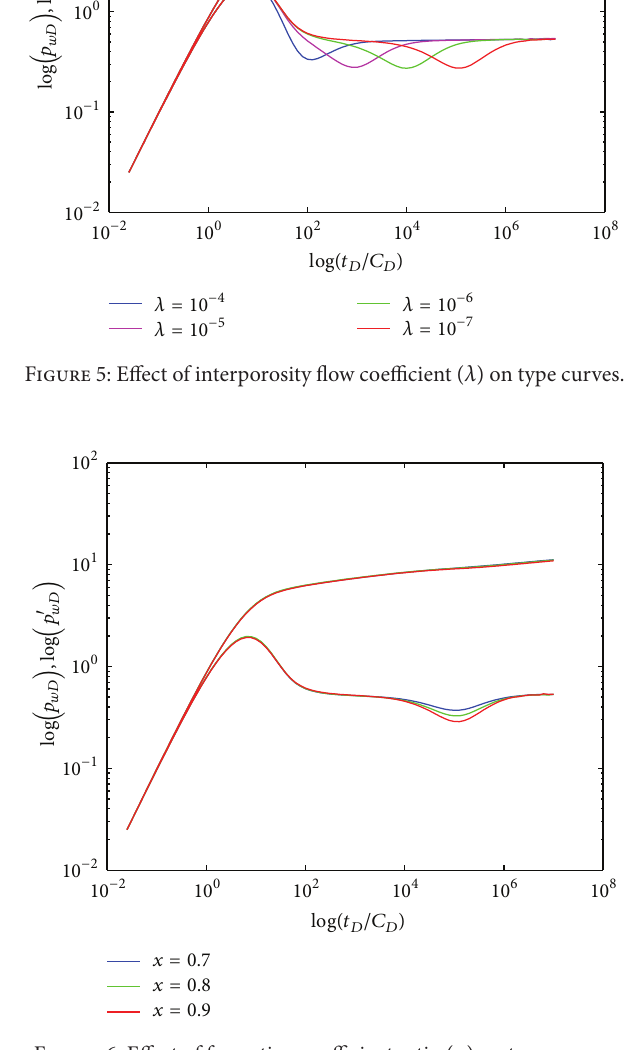
Figure 4: Type curves of well testing in double-layer reservoir by polymer flooding with and without crossflow.